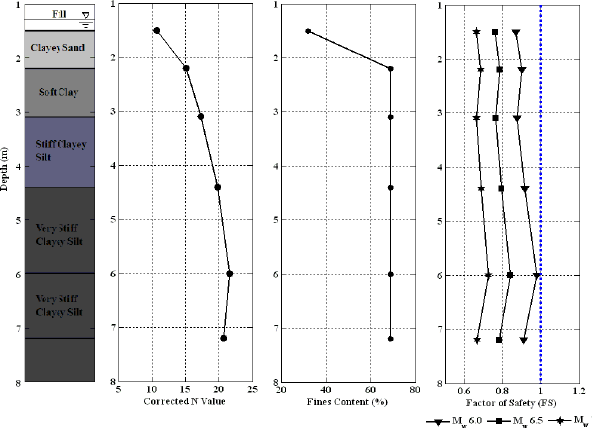
Fig. 4. Soil profile, corrected N values, fine content, FS values against liquefaction along the depth at a typical site (the site is shown as encircled * in Fig. 1).